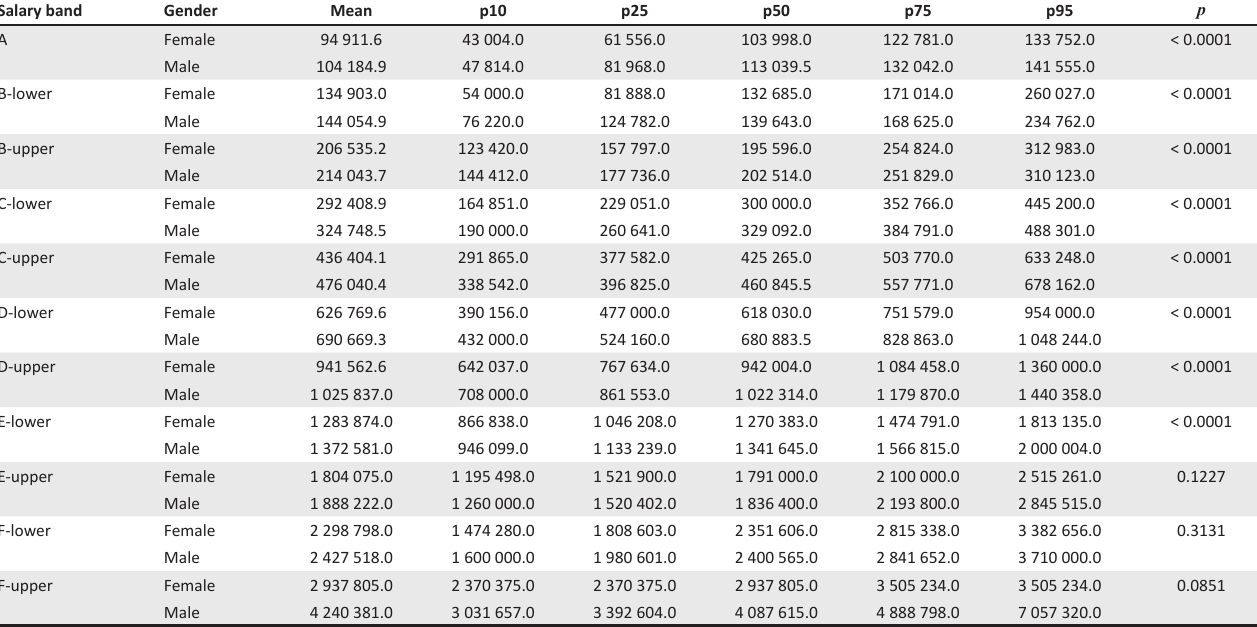
TABLE 4: Assessment of guaranteed package trend per salary band. Salary band